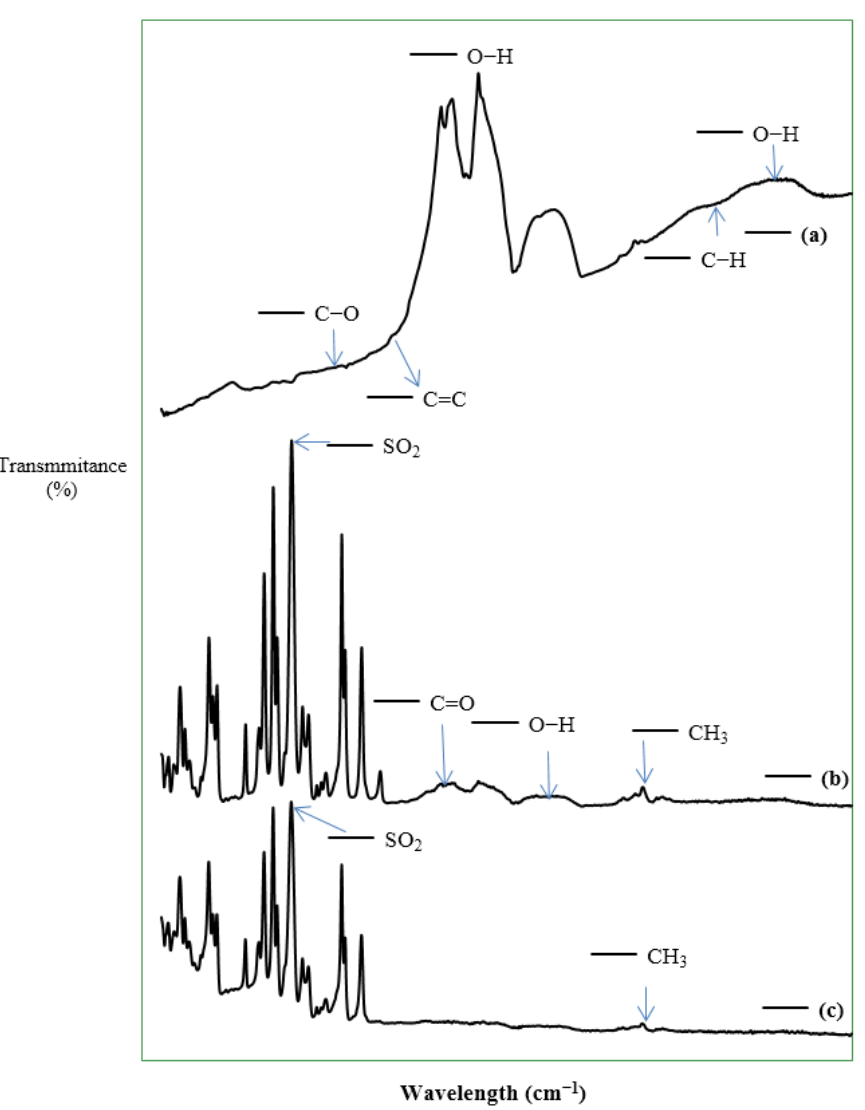
Figure 4. Fourier-transformation infrared (FTIR) spectra showing functional groups. ( a ) CNTs; ( b ) M1; and ( c ) M4.